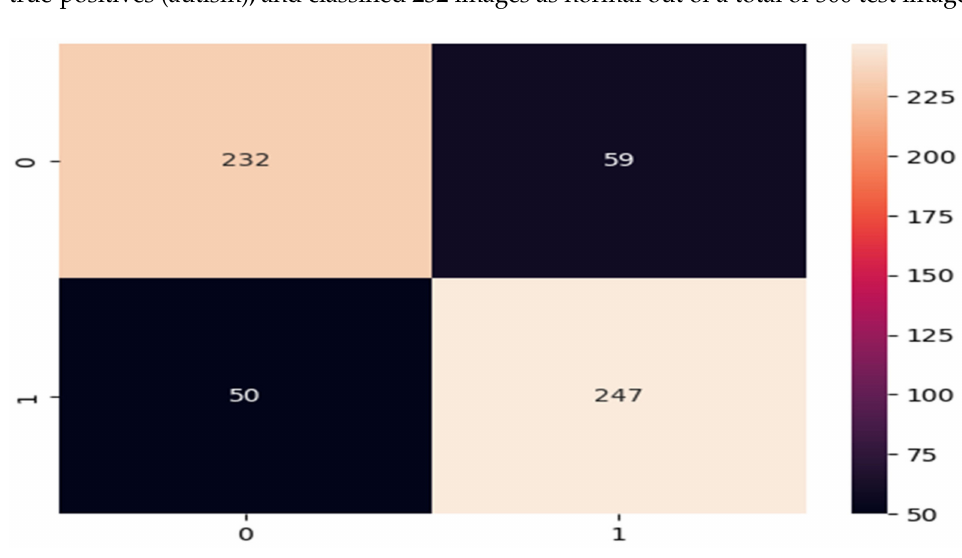
Figure 12. Confusion matrix of VGG-16 with linear